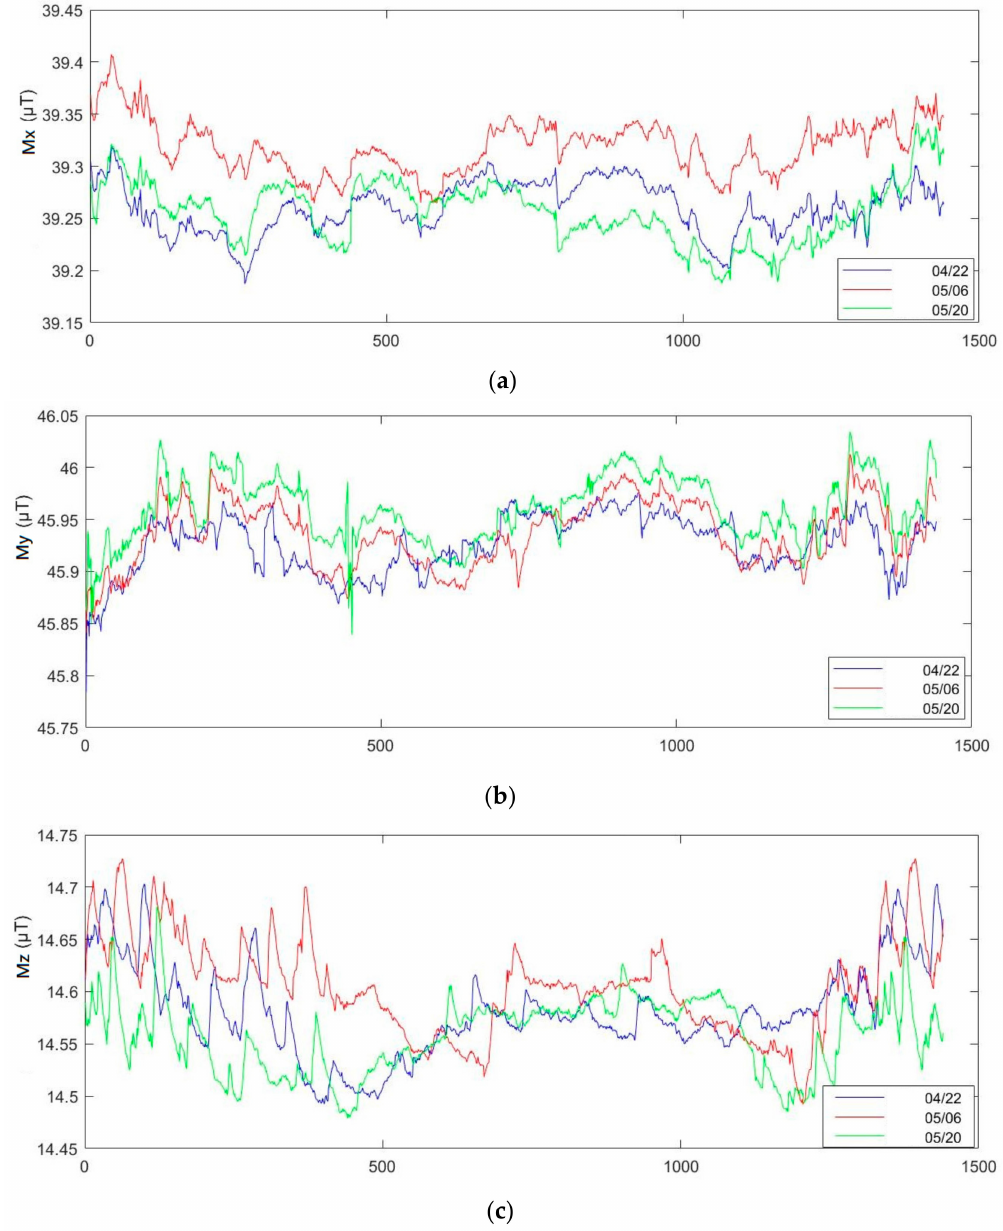
Figure 9. Changes in magnetic field strength collected 14 days apart by: ( a ) sensor X; ( b ) sensor Y; ( c ) sensor